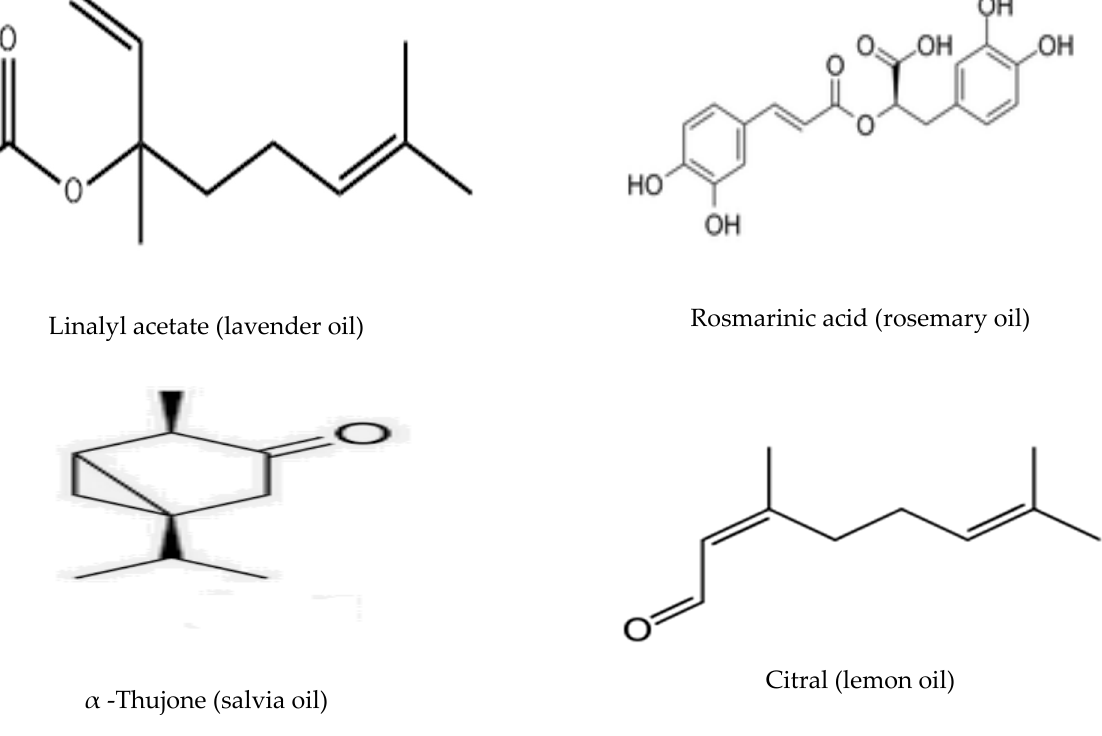
Figure 3. Structures of the main compounds of essential oils.